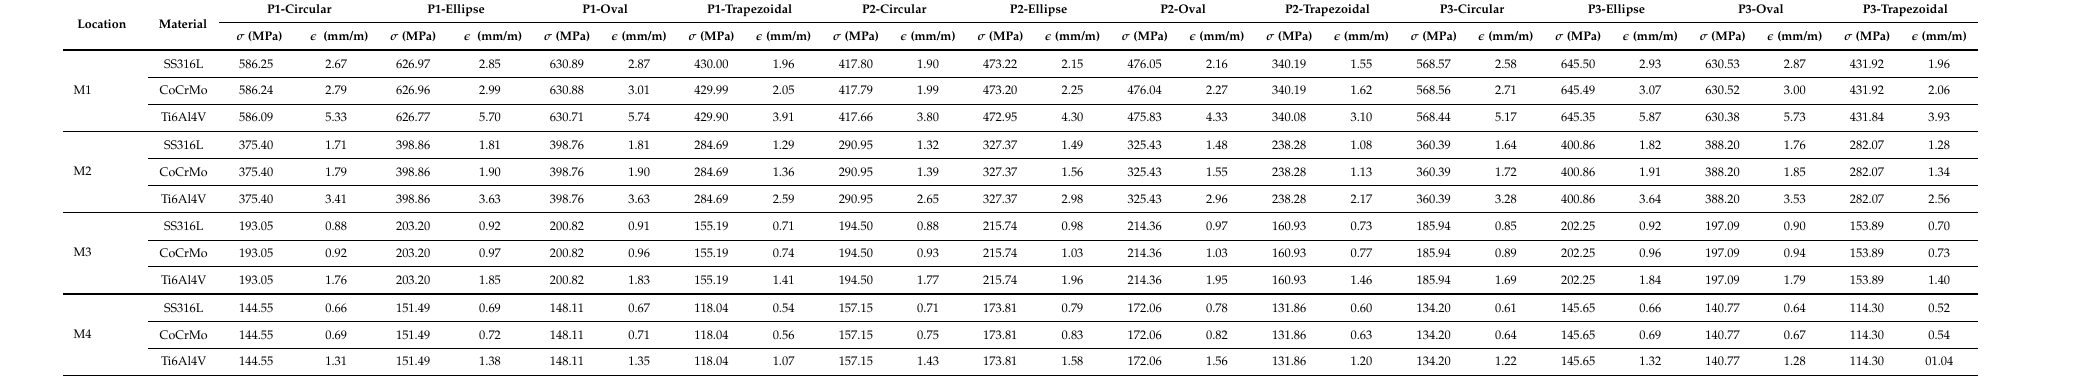
Table A2. Stress and strain analysis on different points in the medial and lateral side of the stem. (Activity 4: Down